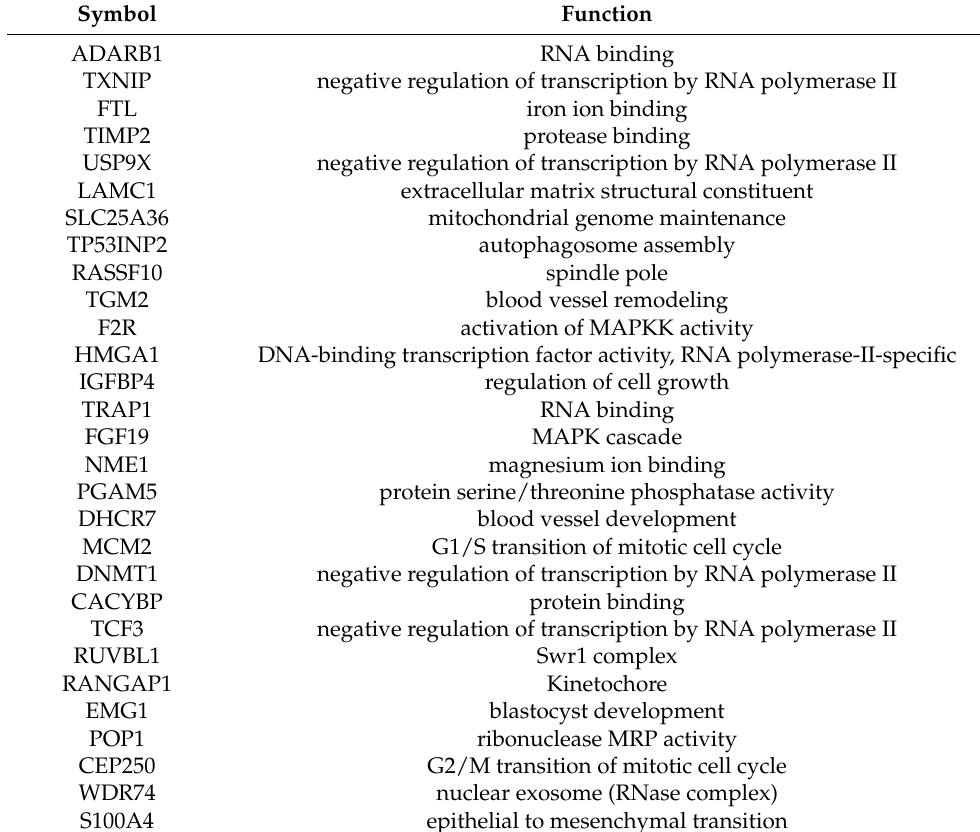
Table 2. A list of the genes that were associated with Wnt signaling was obtained using over- representation analysis based on the ENCODE Histone Modifications gene set library from